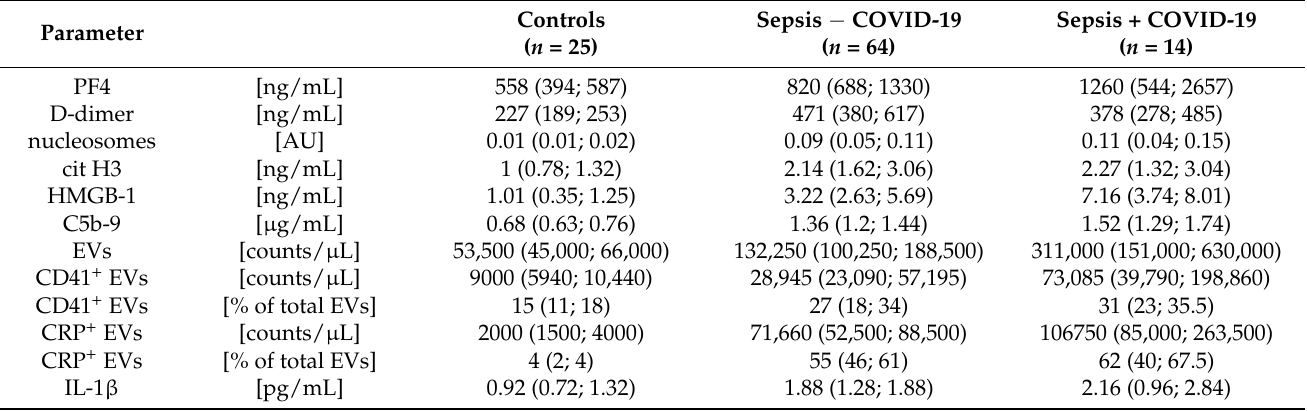
Table 2. Mediator profiles for controls, sepsis patients, and sepsis patients diagnosed with